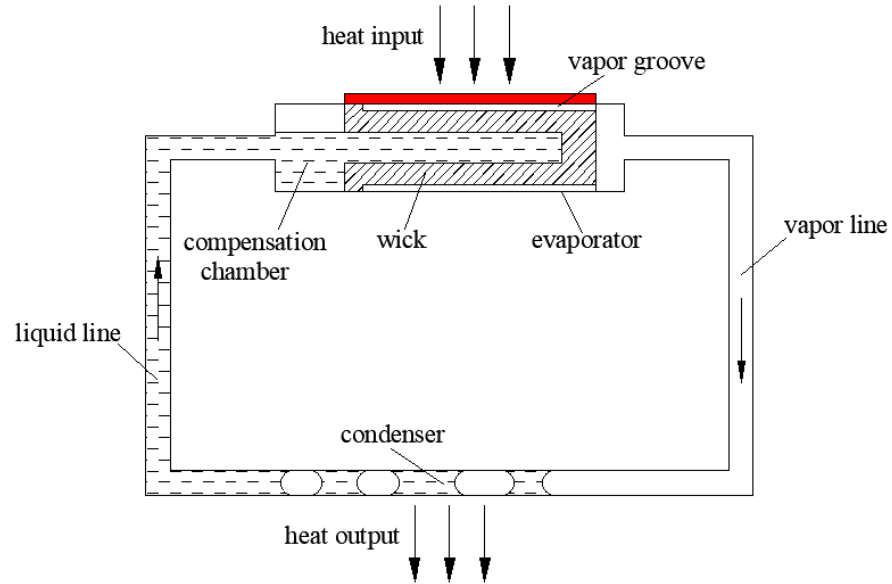
Figure 1. Principal scheme of a loop heat pipe.